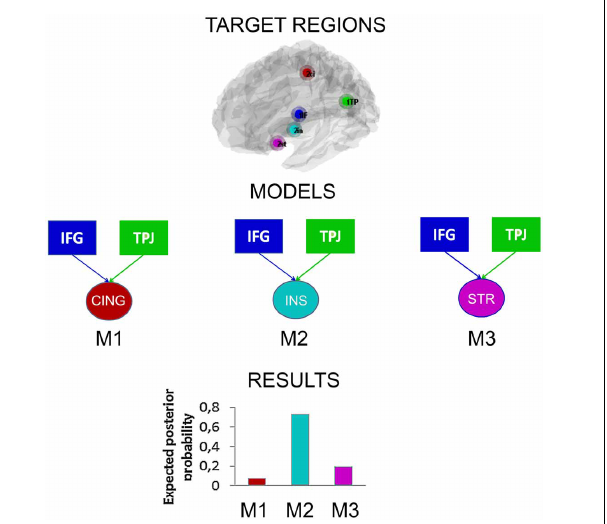
FIGURE 5 | Dynamic causal models. In squares the “Regulating regions” and in circles the “Regulated regions.” Three models were tested. Results showed that a model considering the IFG and TPJ acting as modulators and the insula as the regulated regions is the one that better explains the data.